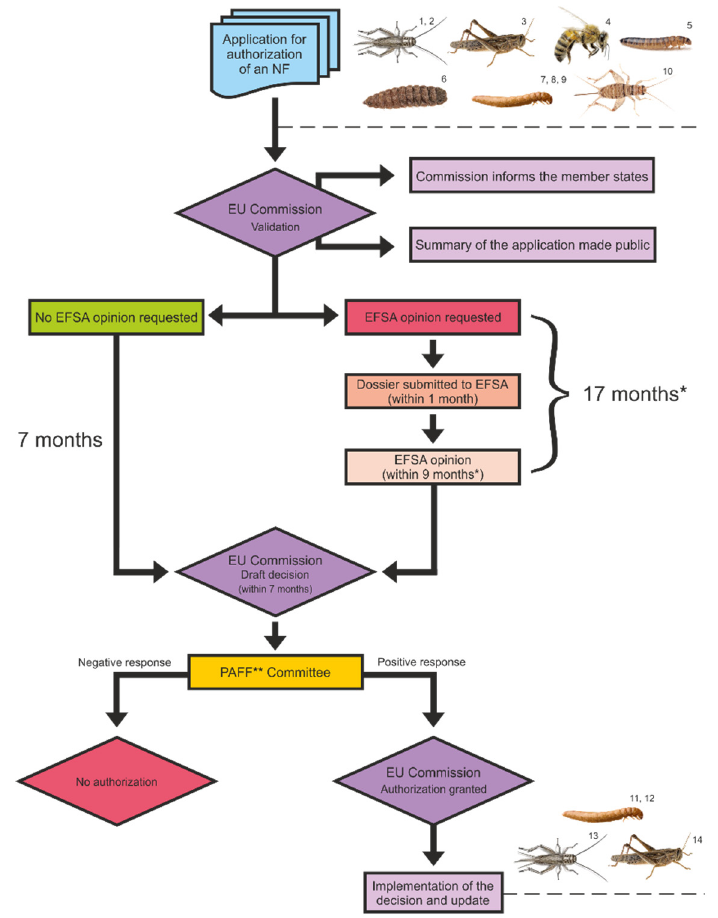
Figure 1. Novel food (NF) authorization process. * This amount of time can be longer if the EFSA requests additional information from the applicant. ** The Standing Committee on Plants, Animals, Food and Feed. 1,2 Acheta domesticus (Belgian Insect Industry Federation—Belgium; Cricket One—Vietnam). 3 Locusta migratoria (Belgian Insect Industry Federation—Belgium). 4 Apis mellifera (Finnish Beekeepers’ Association—Finland). 5 Alphitobius diaperinus (Proti-Farm Holding NV—the Netherlands). 6 Hermetia illucens (Enorm Biofactory A/S—Denmark). 7,8,9 Tenebrio molitor (Nutri’Earth—France; Belgian Insect Industry Federation—Belgium; Ynsect—France). 10